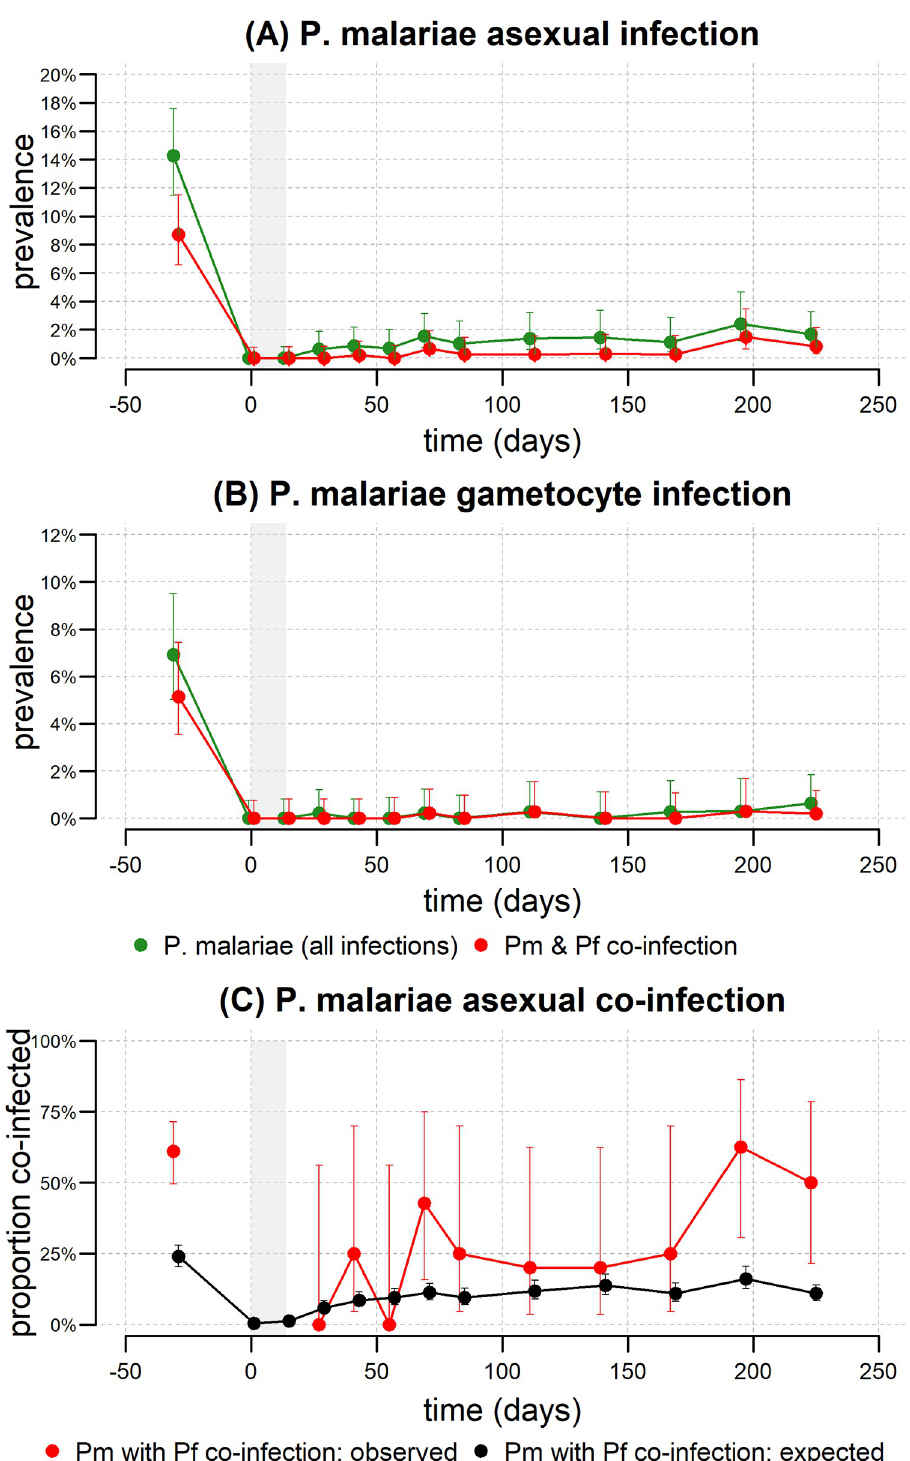
Fig 5. Longitudinal analysis of P . malariae and the effect of co-infection. The prevalence of (A) P . malariae asexual parasites, and (B) P . malariae gametocytes. The prevalence of all P . malariae infections is shown in green, and the prevalence of P . malariae and P . falciparum co-infection is shown in red. The grey shaded region denotes the period of treatment. 5561 samples were included over the entire time period. 123 samples were positive for P . malariae asexual parasites, and 61 of these were co-infected with P . falciparum asexual parasites. 43 samples were positive for P .